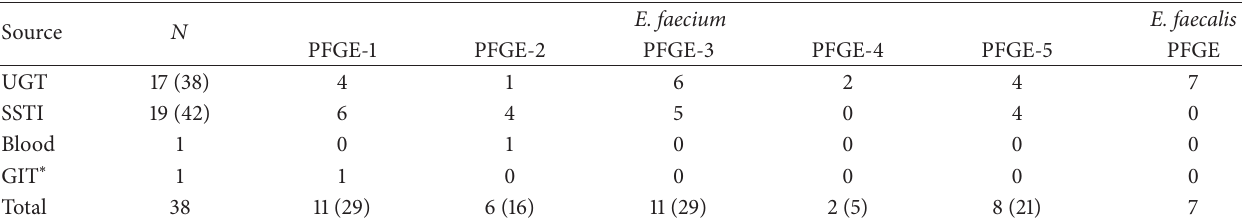
Table 1: Showing various pulsed-field gel electrophoresis (PFGE) groups of 45 vancomycin-resistant enterococcal isolates from regional hospitals in Trinidad and Tobago (%).